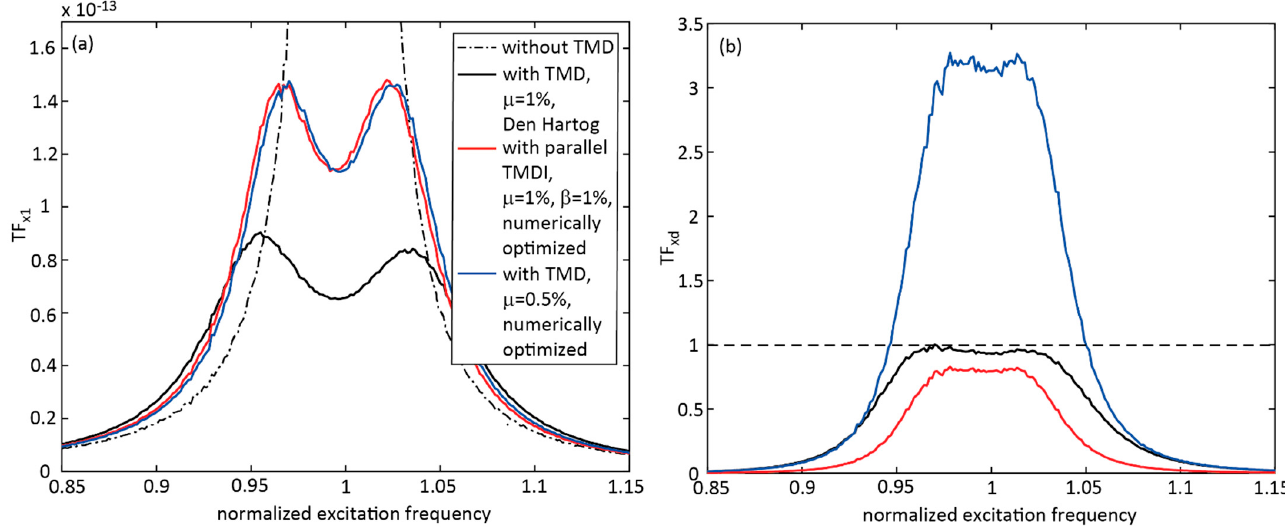
Figure 7. Performances of TMDI with inerter in parallel to stiffness and viscous damper ( 𝜇 = 1%, 𝛽 = 1%, numerically optimized parameters), TMD ( 𝜇 = 1%, Den Hartog parameters) and TMD ( 𝜇 = 0.5%, numerically optimized parameters) for random excitation: ( a ) primary structure normalized displacement response and ( b ) normalized damper relative motion